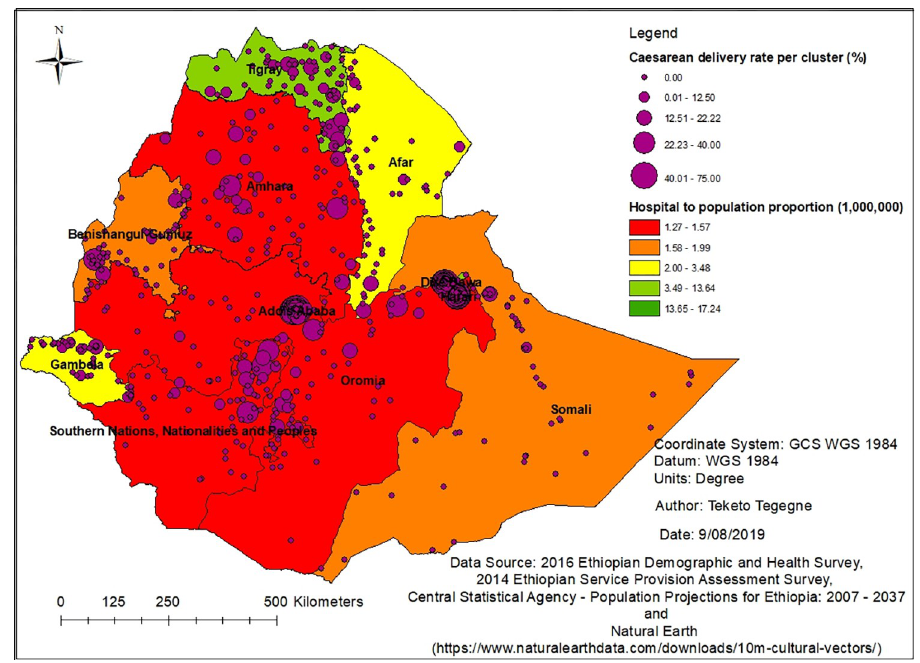
Fig 3. Distribution of hospitals and caesarean delivery rate in Ethiopia,